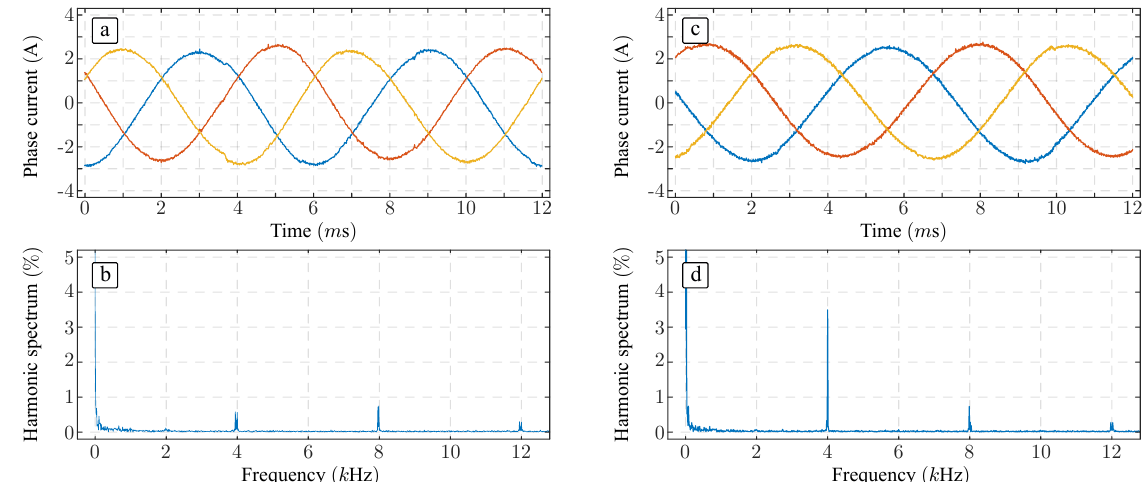
Figure 14. Results applying the traditional PWM method with [ φ a , φ b , φ c ] = [ 0,0,0 ] ◦ ( a ) Phase currents ( b ) Harmonic spectrum of phase a current. Results applying the PWM method with [ φ a , φ b , φ c ] = [ 0,120,240 ] ◦ ( c ) phase currents ( d ) Harmonic spectrum of phase a